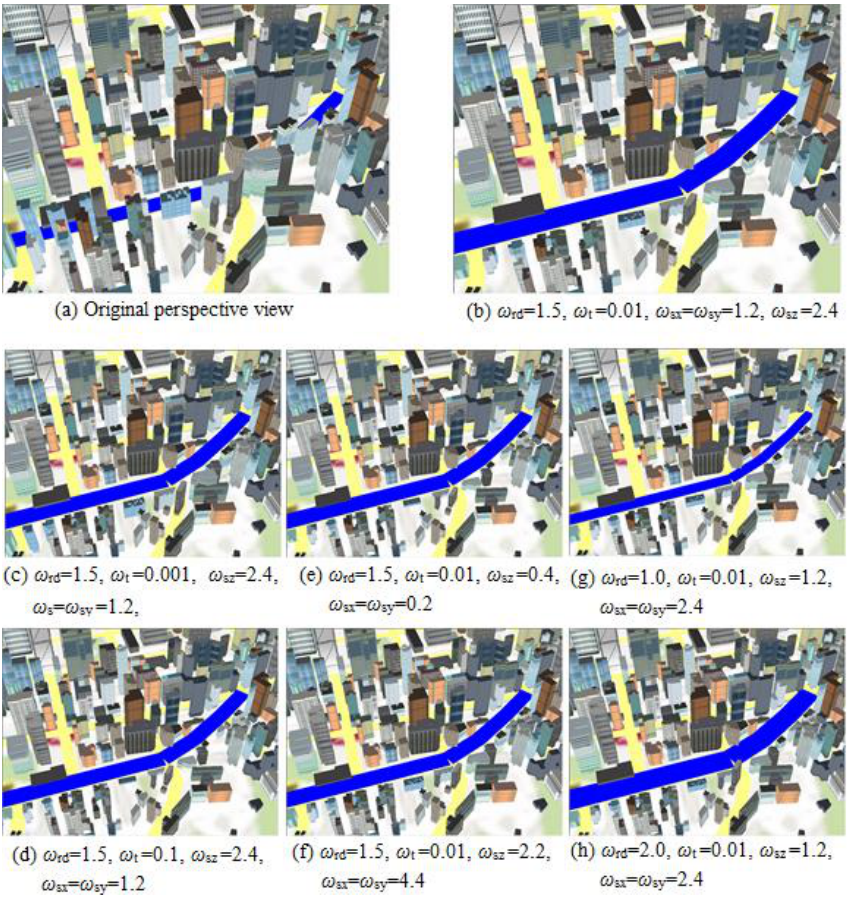
Figure 13. Occlusion-free views with different weights: ( a ) original perspective view; ( b ) occlusion-free view with predefined weights; ( c , d ) occlusion-free views with different ω t values; ( e , f ) occlusion-free views with different ω s values; and ( g , h ) occlusion-free views with different ω rd values.